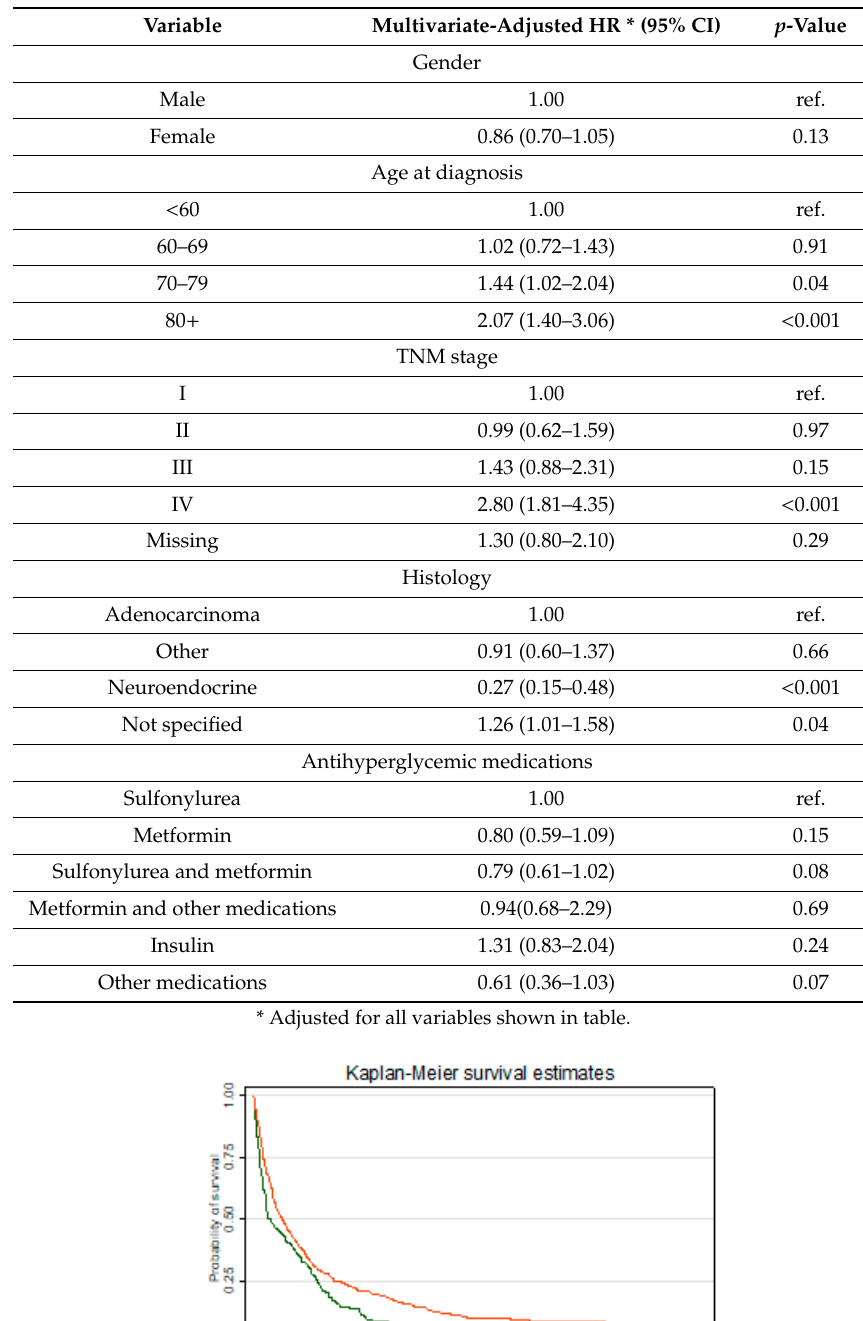
Table 2. Hazard ratio (HR) and 95% Confidence Interval (CI) of the association of glucose-lowering therapies, and overall mortality in diabetic pancreatic cancer patients.